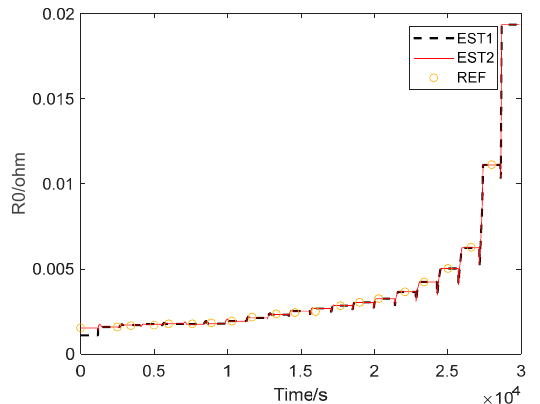
Figure 12. The online estimation of R 0 .